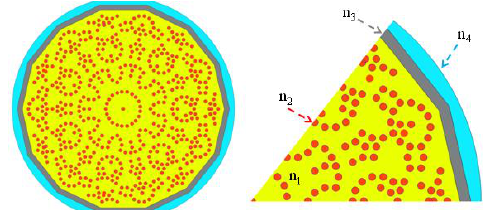
Figure 1. Simulated decagonal mesa geometry with the main dielectric area having refractive index n 1 = 3.6, filled by circular scatters having refractive index n 2 . A surrounding region with a 35 μm width and a complex effective index of n 3 = 3.6 + i was used to model the absorbing layer, defining smooth boundary conditions for the guided modes. An external region, having n 4 = 1.0 and being terminated by scattering boundary conditions, was used to model the open boundaries outside the mesa device.